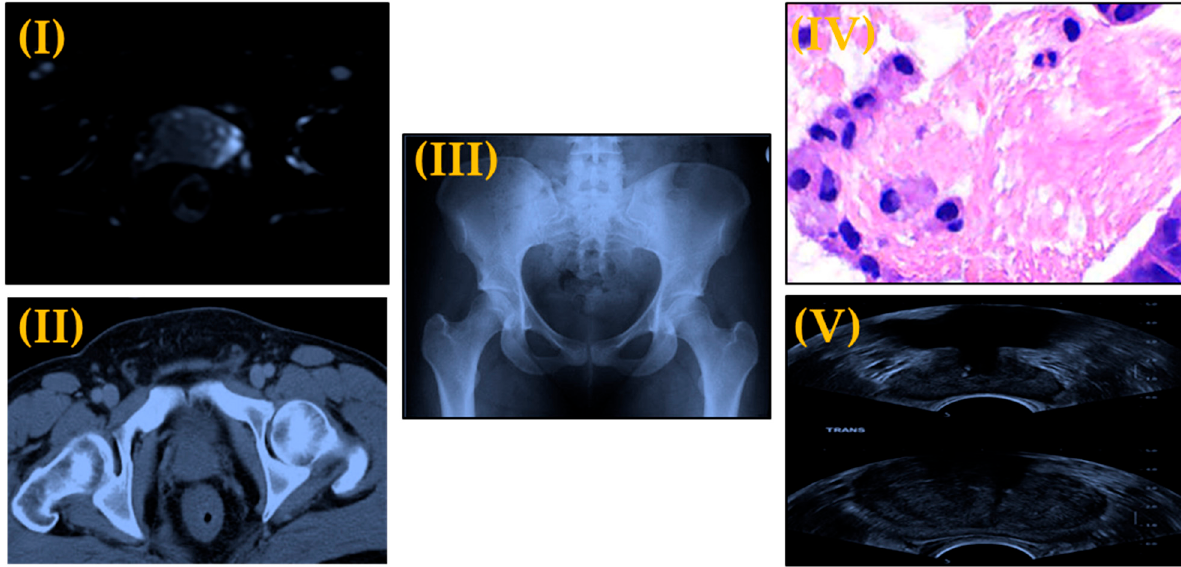
Figure 1. Different Types of Medical Images ( I ) MRI image of prostate, ( II ) CT image of prostate, ( III ) X-Ray image of prostate pelvic area, ( IV ) Histopathological image of prostate tissue, and ( V ) Ultrasound for prostate biopsy.